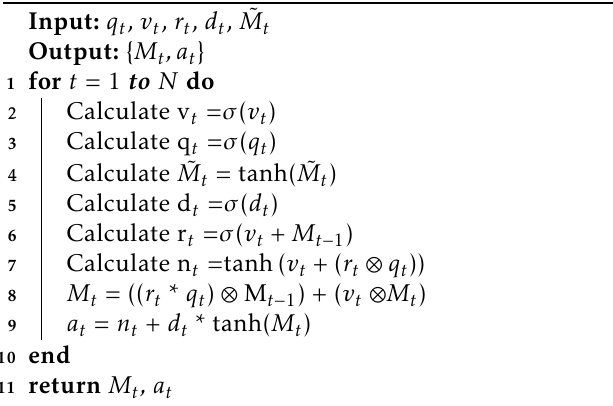
Algorithm 1: Viewport